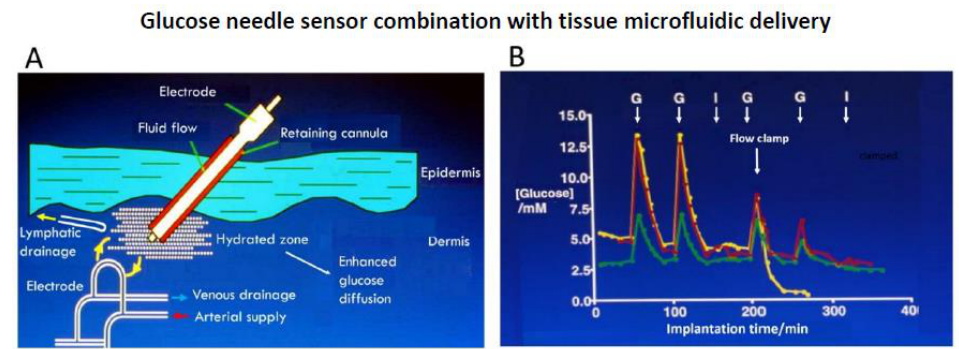
Figure 10. ( A ) Schematic of subcutaneously implanted glucose needle electrode within open ended cannula for delivering fluid around the implanted sensor to create a limited hydrated zone. ( B ) Subcutaneous glucose monitoring in rat ( ) venous blood glucose, tissue glucose at 60µL/h microflow ( ) and at a constrained flow of 10µL/h ( ) showing underestimated glucose and total loss of response with clamped flow. Bolus tail vein administration of glucose (G) and insulin (I). Adapted from [83].